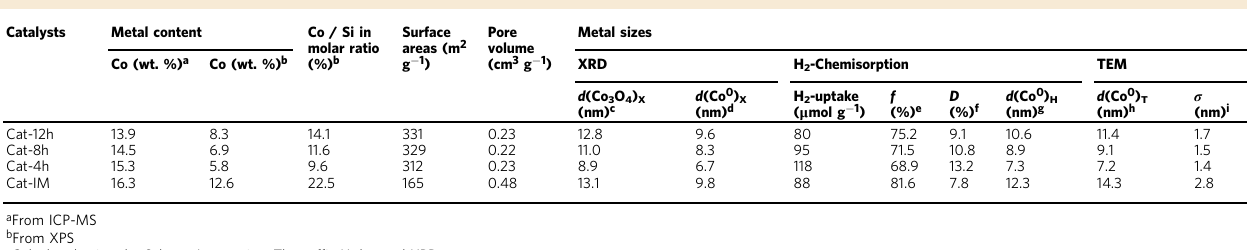
a From ICP-MS b From XPS c Calculated using the Scherrer ’ s equation. The suf fi x X denoted XRD d Calculated applying the molar volume correction: d ð Co 0 Þ X ¼ 3 e Reduction degree f Metal dispersion g The suf fi x H standing for H 2 -chemisorption h From TEM images. The suf fi x T standing for TEM